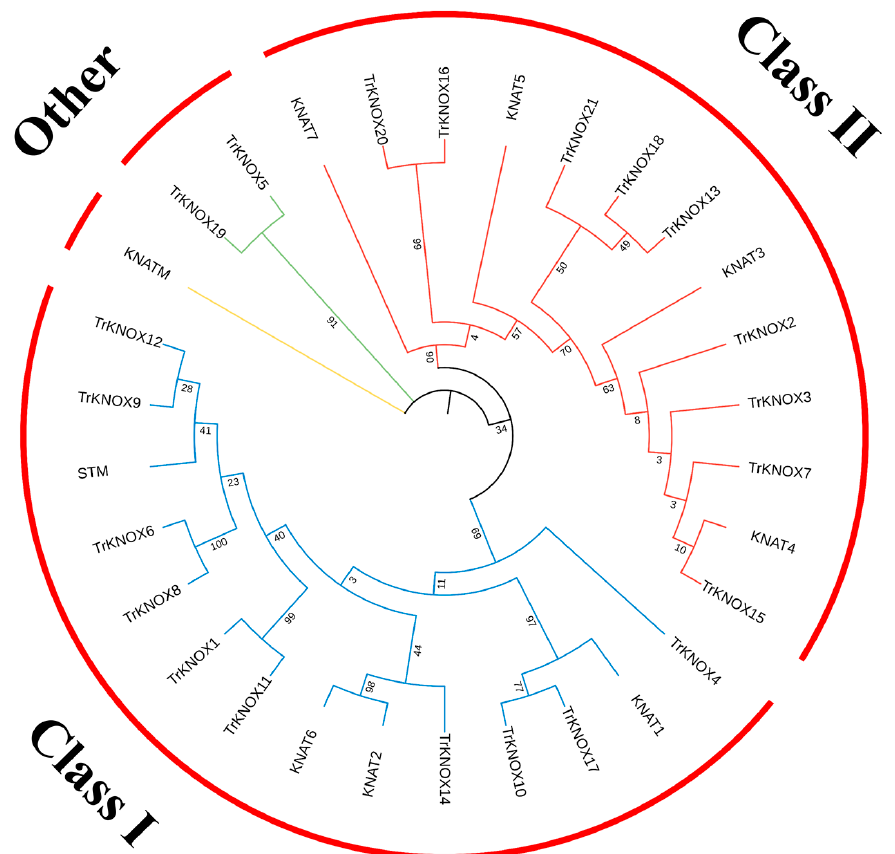
Figure 1. An unrooted phylogenetic tree showing relationships between the KNOX family proteins in T. repens and A. thaliana . The tree divided the TrKNOX proteins into three subclasses. Neighbor- joining (NJ) was used to derive the phylogenetic trees.